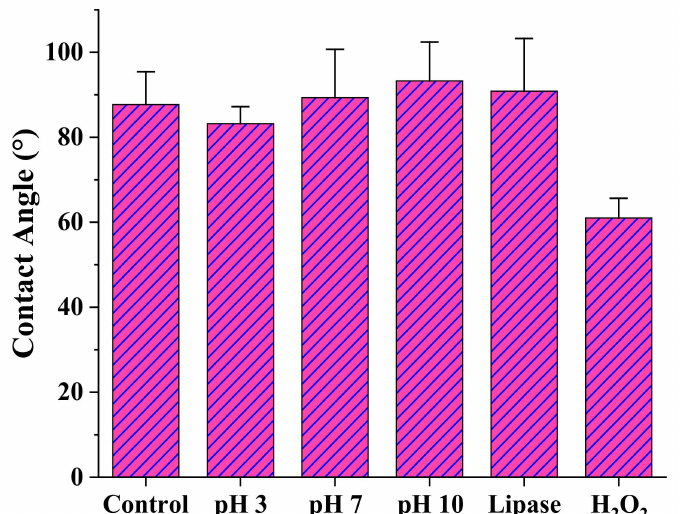
Figure 9. Contact angle measurements over the surface of poly(PA-LO) tablets after exposure to the indicated media for 21 days.